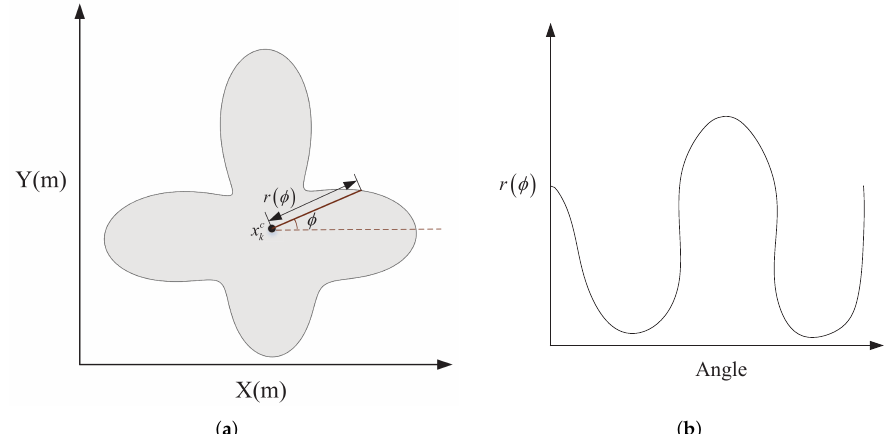
Figure 1. Representation of a star-convex shape using a radial function. ( a ) Star-convex extended target. ( b ) Radial